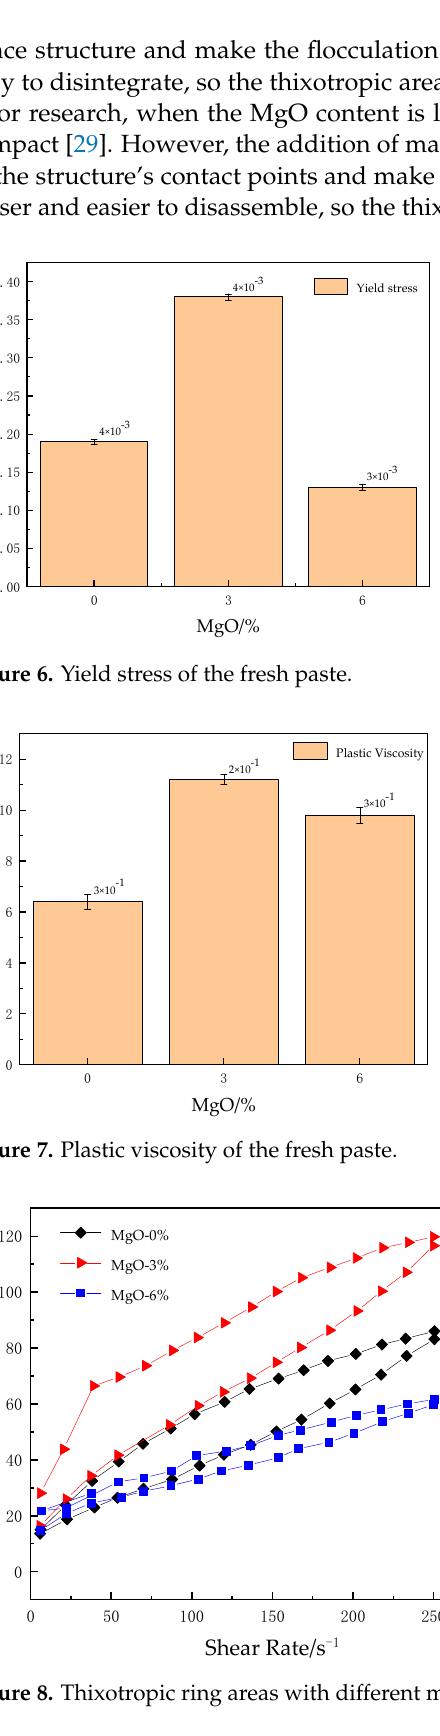
Figure 6. Yield stress of the fresh paste.